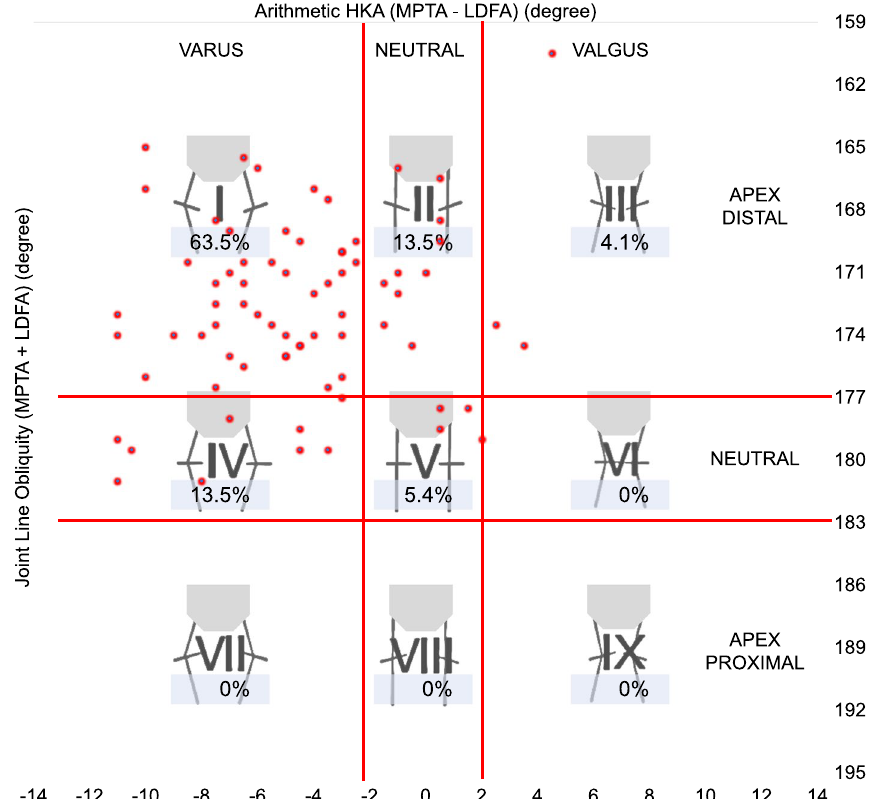
Fig. 3 Plot of arithmetic hip-knee-ankle angle (HKA) against calculated joint line obliquity for the preoperative population included in this study, showing distribution by percentage of the nine Coronal Plane Alignment of the Knee (CPAK) phenotypes. The arithmetic HKA and joint line obliquity were calculated by the difference and sum of MPTA and LDFA as reported by MacDessi et al. [27]’s Coronal Plane Alignment of the Knee (CPAK) classification. Abbreviations: LDFA: lateral distal femoral angle; MPTA: medial proximal tibial